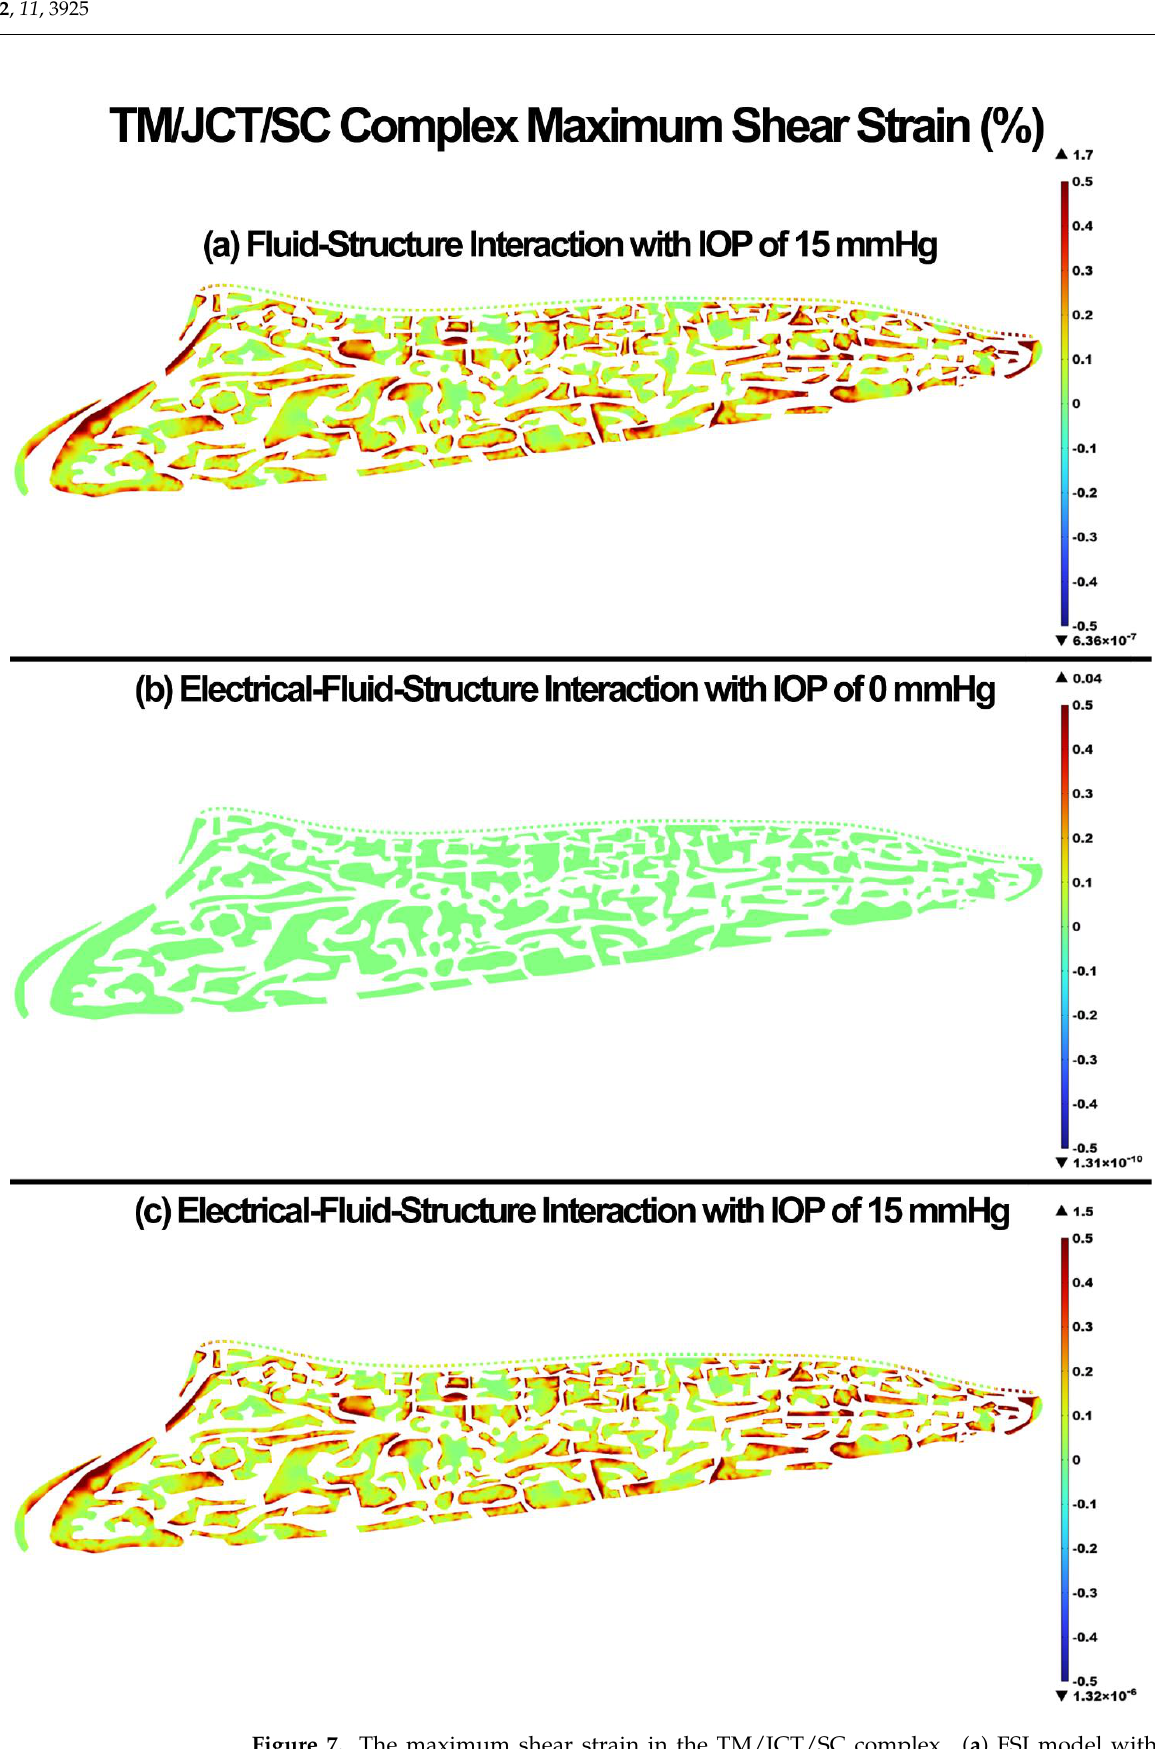
Figure 7. The maximum shear strain in the TM/JCT/SC complex. ( a ) FSI model with IOP of 15 mmHg, ( b ) EFSI with IOP of 0 mmHg, and ( c ) EFSI with IOP of 15 mmHg.